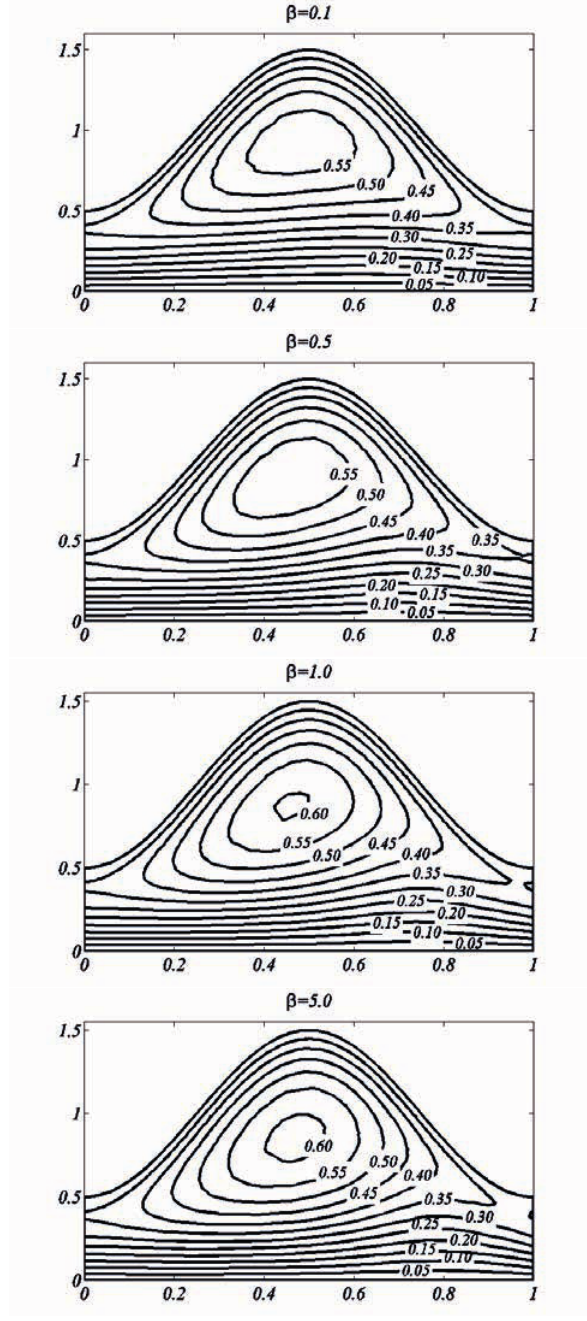
Fig. 8: Variation of streamlines against different values of β in wave frame with Re = 10, M = 2, α = 0.2, φ = 0.5, Q = 1.3 .